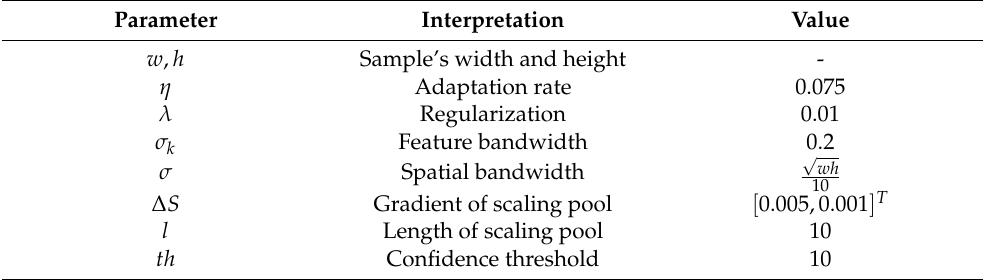
Table 2. Key parameters